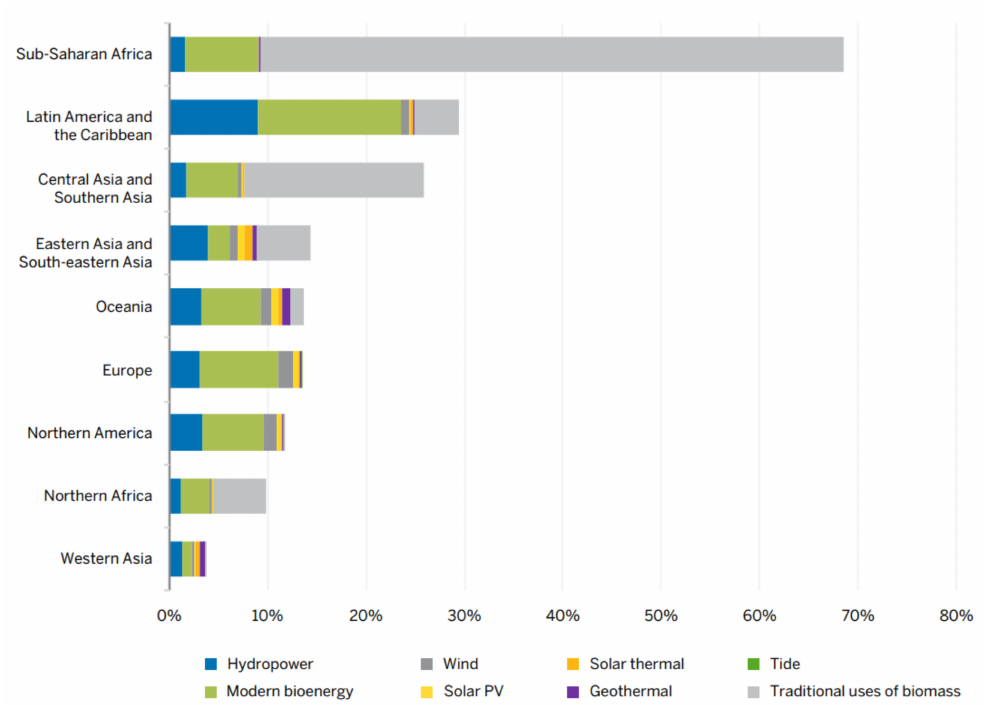
Figure 1. Renewable share in total final energy consumption different regions, 2017